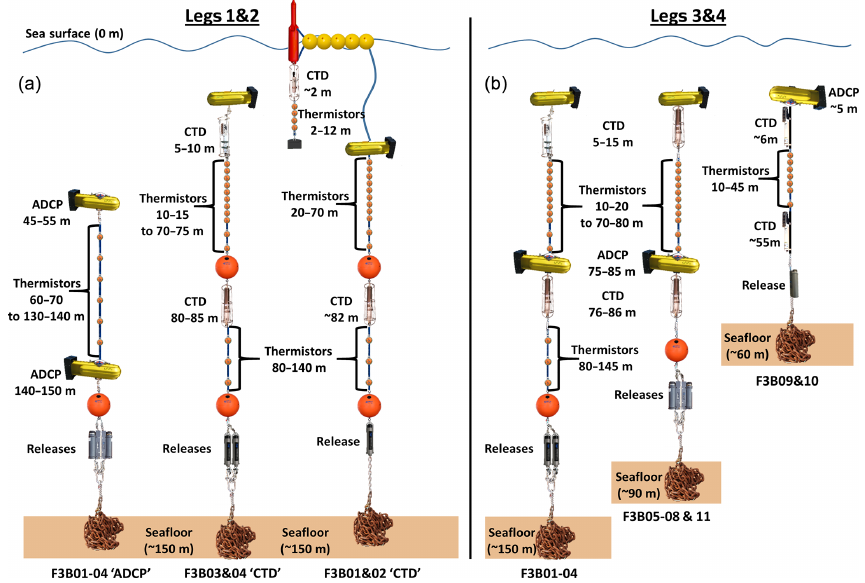
Figure 2. DFO taut line moorings: legs 1 and 2 (a) ; legs 3 and 4 (b) . In leg 2, F3B01 and F3B02 CTD lines were converted to the F3B03 and F3B04 design due to failures of the sea-surface part. A 110m rope, without thermistors, was added under the bottom CTD of F3B08 to be